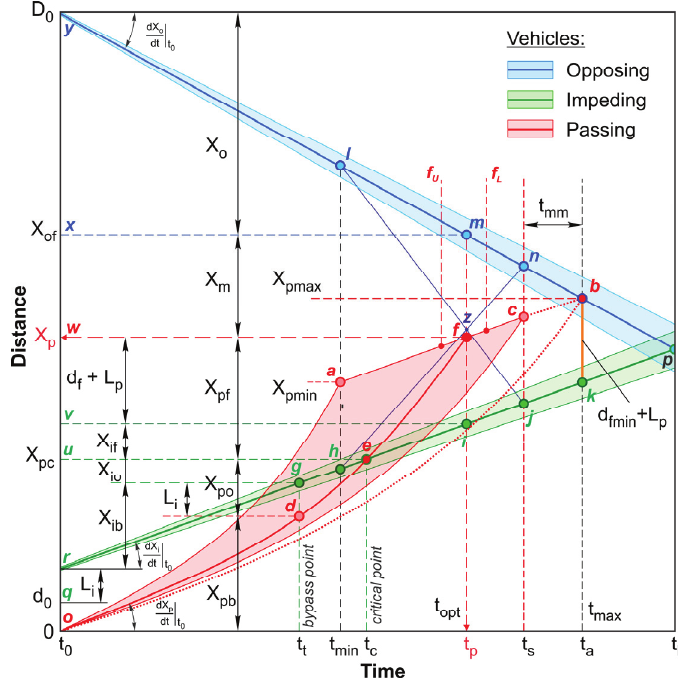
Figure 3. Logic for selecting rational values of time and distance for overtaking.